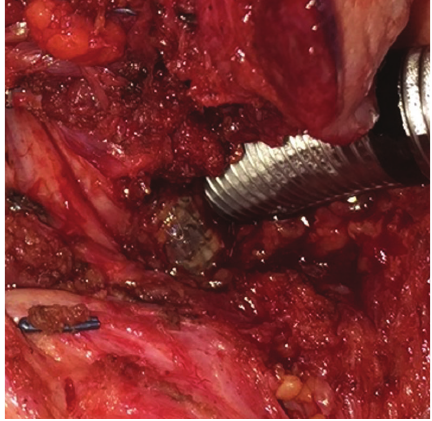
Figure 3: Intraoperative view of exposed carotid stent juxtaposed to